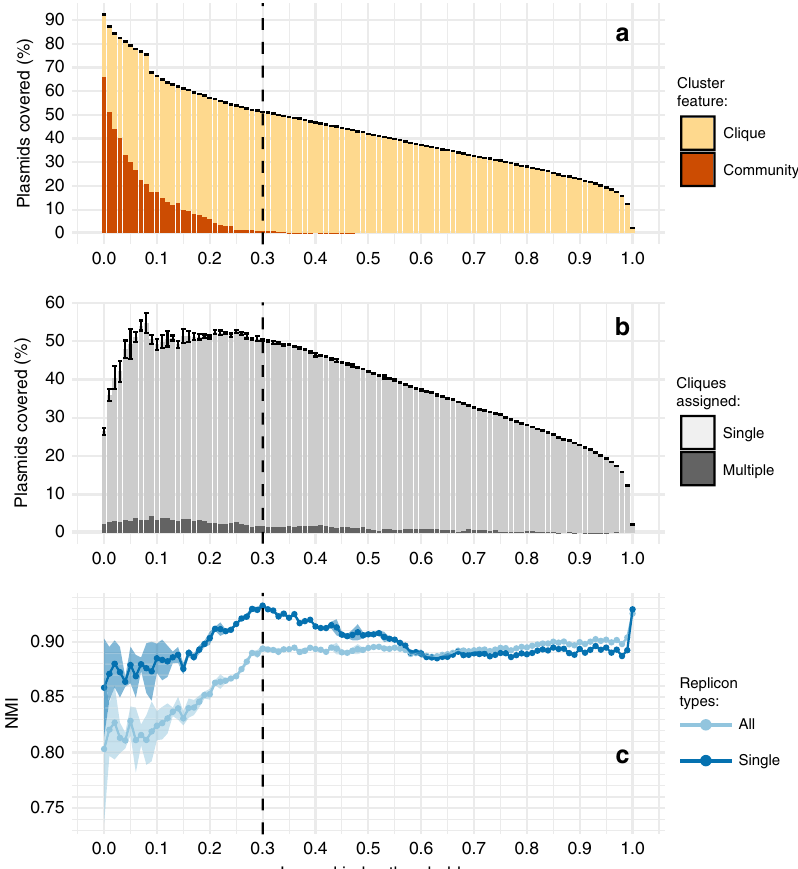
Fig. 2 Optimization of OSLOM performance. A range of Jaccard index (JI) thresholds were applied to the original plasmid network (Supplementary Fig. 3) with edges below a particular threshold being removed prior to OSLOM analysis. During the process, several criteria were considered: a clique to community ratio; b percentage of plasmids covered by the cliques; c the congruence with replicon typing measured by NMI score. NMI was calculated for all cliques containing plasmids assigned to a single or multiple replicon types (legend: All) and just to a single replicon type (legend: Single). Error bars ( a , b ) and light-coloured shading ( c ) provide ±2 standard deviations (SDs) of uncertainty. Standard deviation around every value on the y- axis across all JI thresholds assessed (points and bars) was calculated based on results of n = 5 iterations of the OSLOM software (see ‘ Methods ’ ). The dashed vertical line indicates the selected optimal JI threshold of